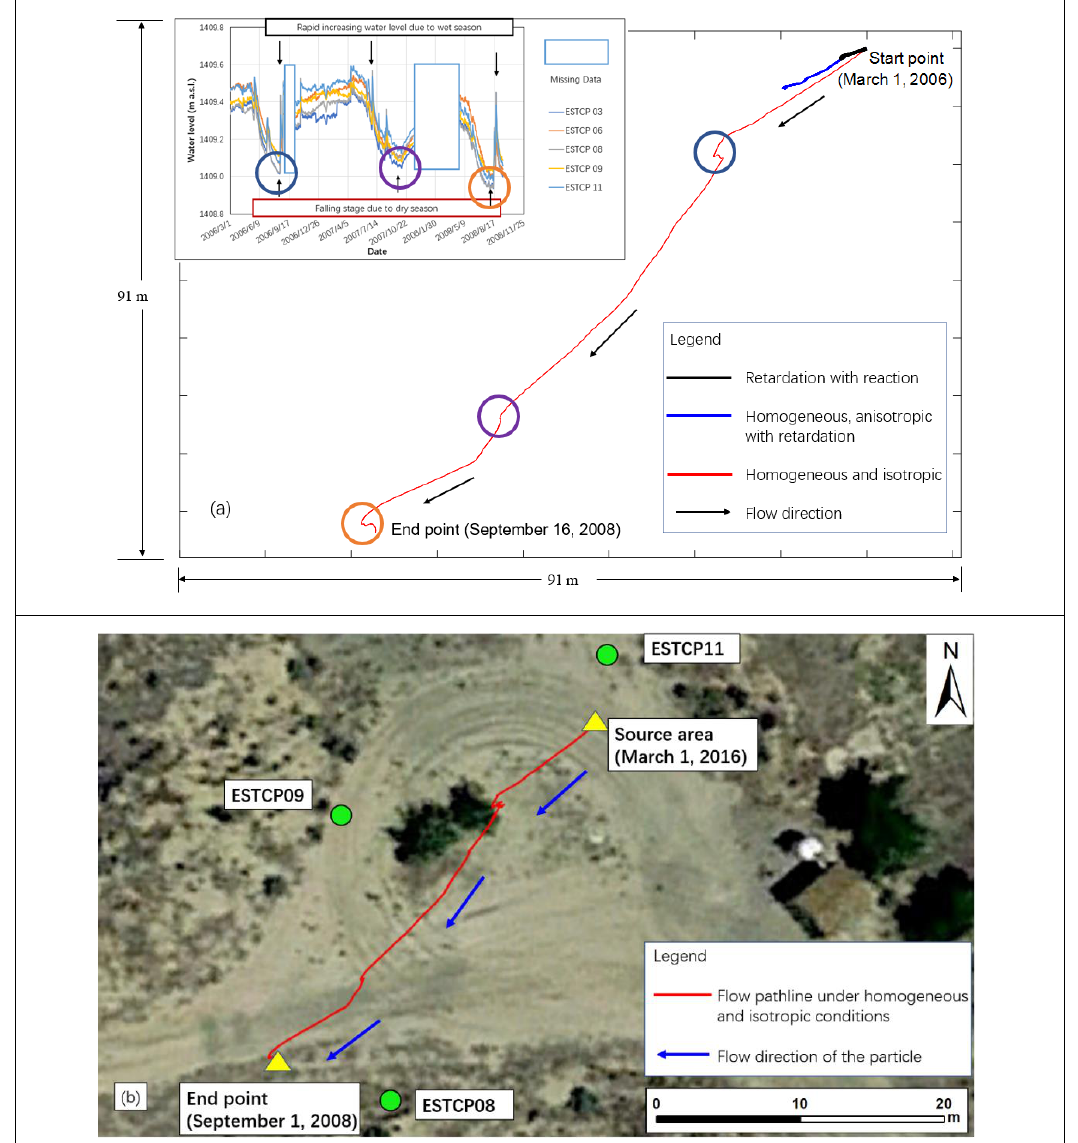
Figure 6. ( a ) Flow pathline of particle tracked under in different geologic conditions at Pueblo chemical depot in Pueblo, CO (circles with specific color correspond to flow direction reversals). ( b ) Flow pathline of particle tracked under homogeneous and isotropic conditions by assuming a source area at the study site.